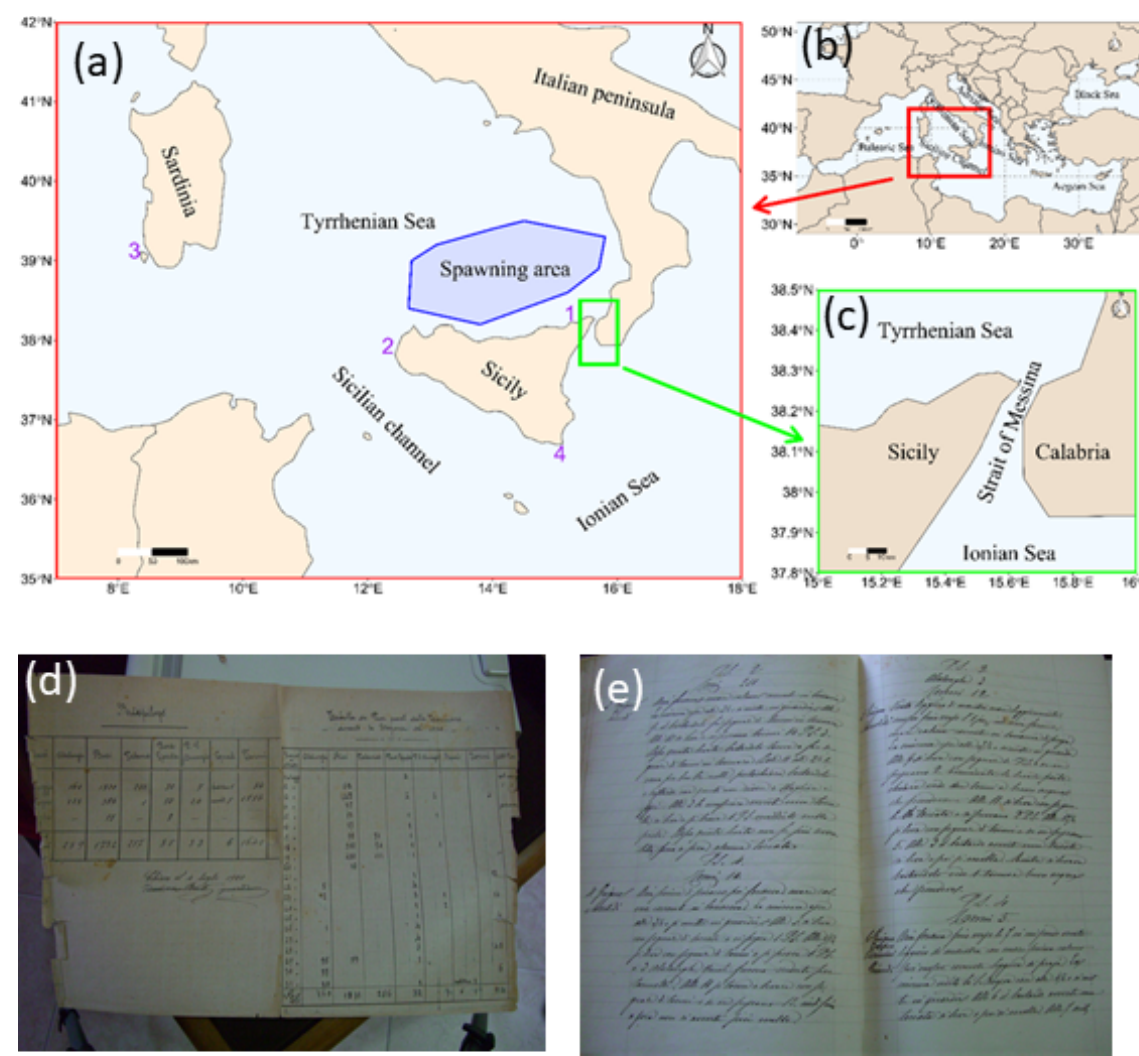
Figure 1. Panels (a–c) Maps showing locations of bluefin tuna traps whose swordfish bycatch data were retrieved from historical fishing reports and accounts and geographic features mentioned in the text. Blue area on map in panel (a) indicates the approximate location of the swordfish spawning area. Photos below (panels d and e ) the maps show examples of pages from the fishing record books for the Milazzo